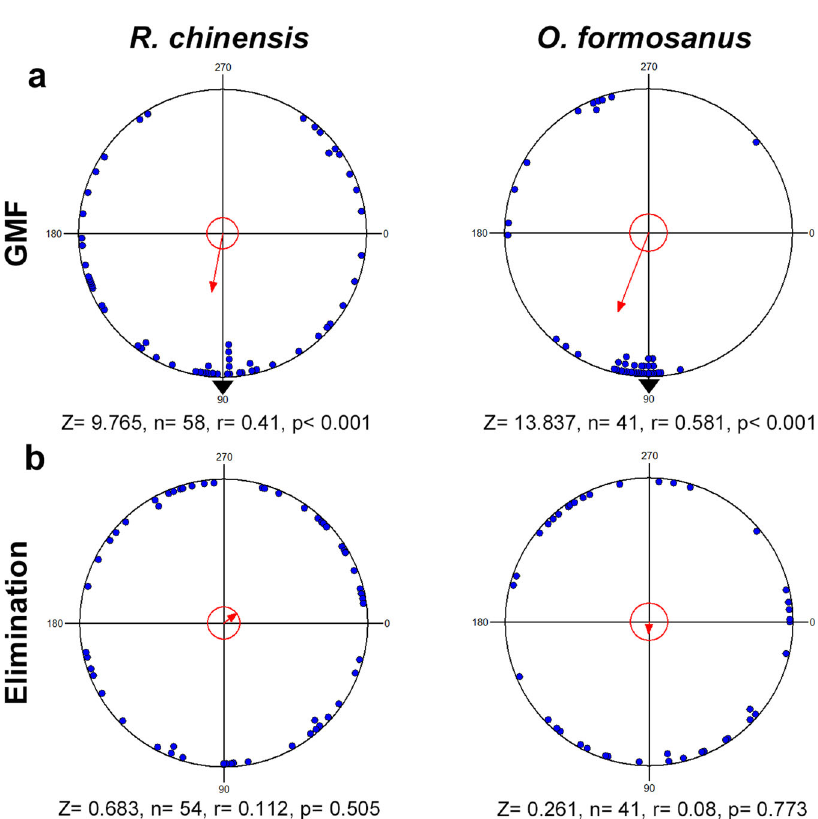
Fig. 2 Termites orient with respect to the direction of the GMF in a radial pheromone maze. a Effect of the GMF on heading direction in a radial pheromone maze. b Effect of eliminating the horizontal component of the magnetic fi eld on heading direction in a radial pheromone